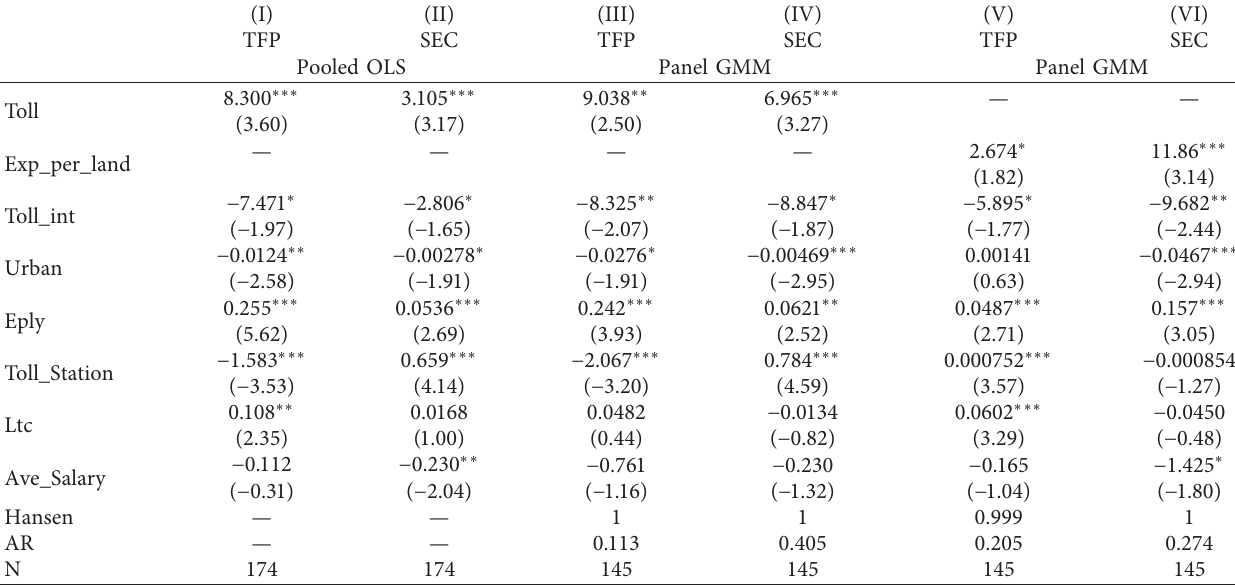
Table 7: Parameter estimation results.